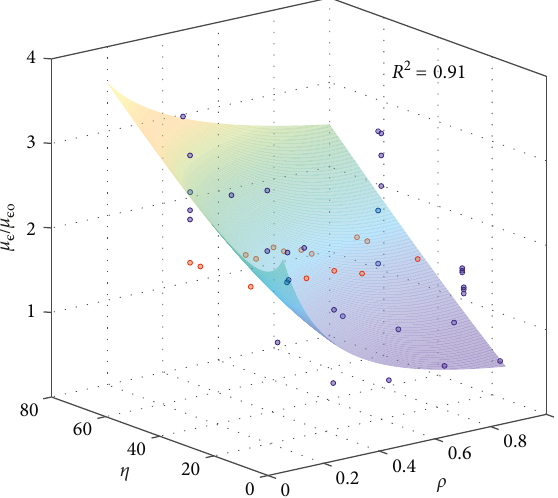
Figure 8: 3D figure of Equation (6) in terms of μ experimental data (blue points) and the numerically simulated data (red